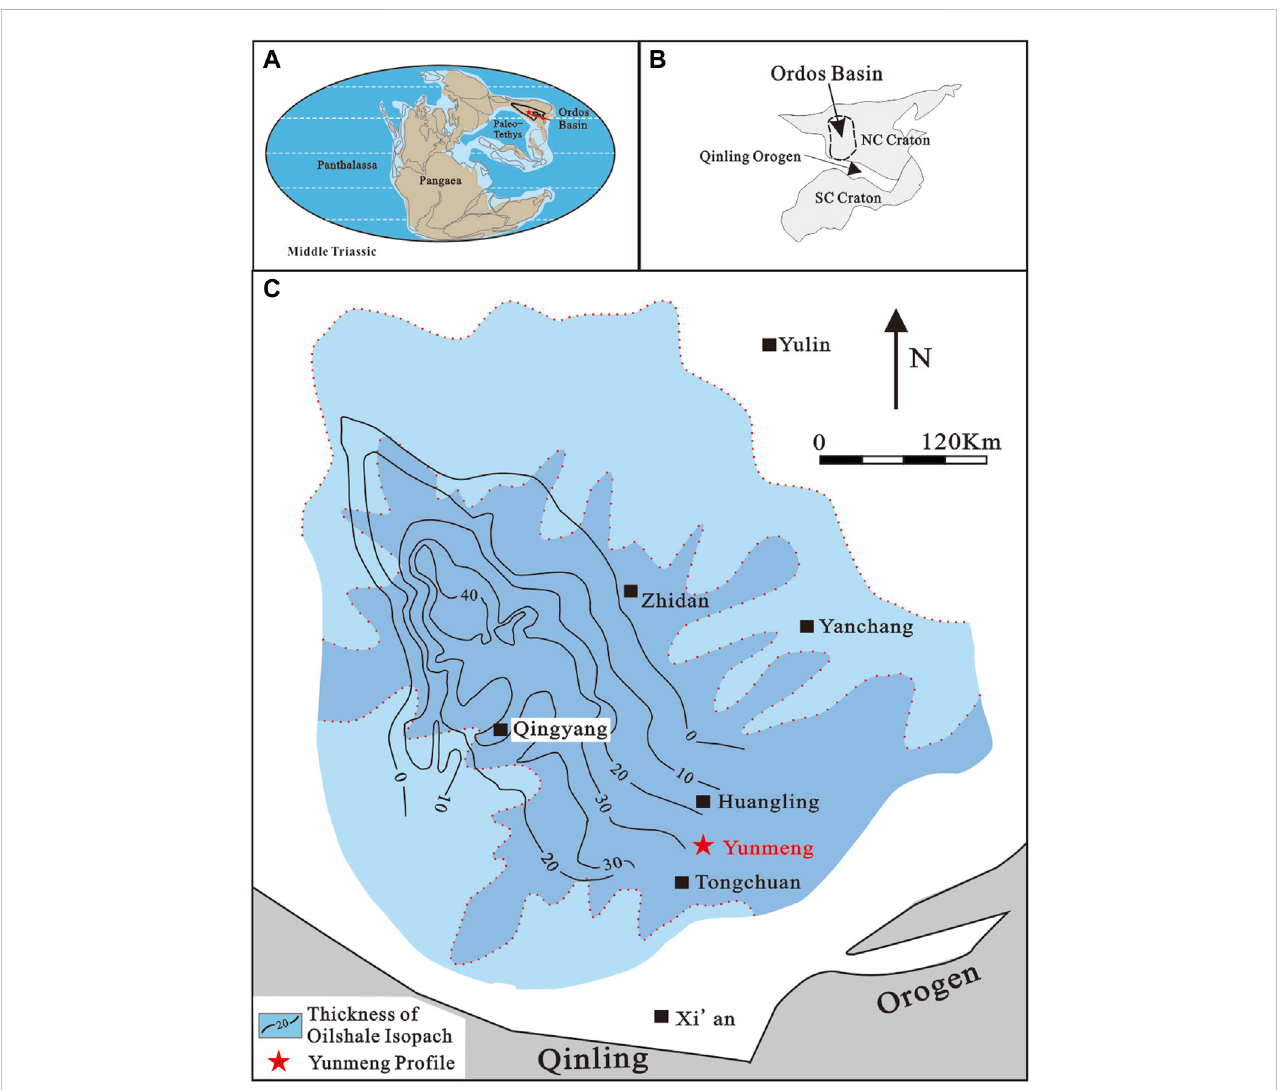
FIGURE 1 Geographical and geological location of the Yunmeng Pro fi le in the Ordos Basin (after Sun et al., 2020). (A) Reconstructed topography in late Middle Triassic (after Zhang et al., 2019). (B) Geographic map of China showing location of the Ordos Basin; NCCraton, North China Craton; SC Craton, South China Craton. (C) Paleogeographic map of YC7 showing the isopach of